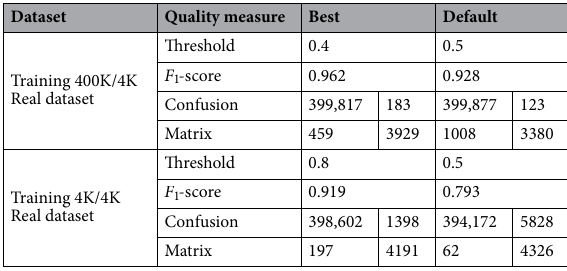
Table 3. Baseline results using real data for